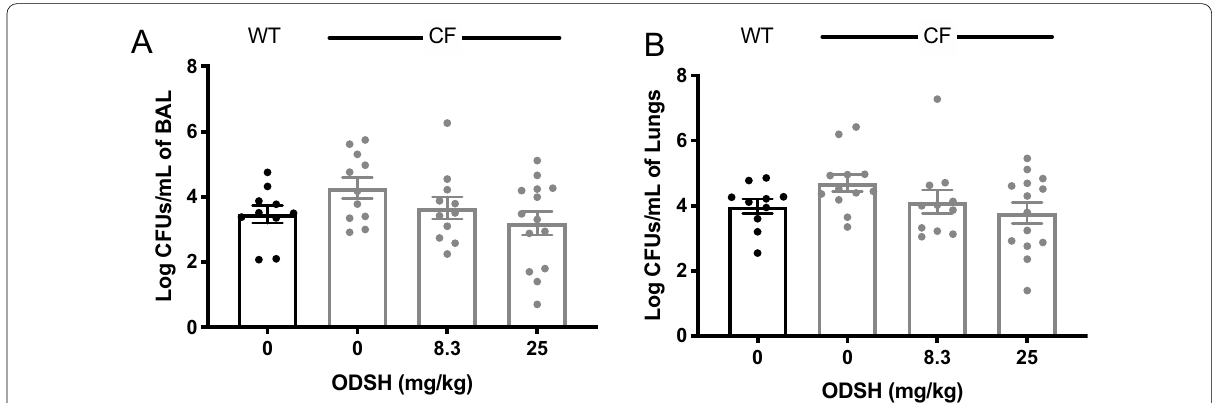
Fig. 2 ODSH improves bacterial clearance in BALF and lung tissues of CF mice. C57BL/6 mice (WT) and CFTR −/− mice (CF) were intratracheally inoculated with Pseudomonas aeruginosa (PA) at T 0 and were randomized to receive via i.p. administration of saline or ODSH at 8.3 or 25 mg/kg = at T 0 and 12 h. A Bronchoalveolar lavage fluid (BALF) and B lung homogenate were harvested 18 h after infection (T 18 h) and were analyzed = = for the amount of viable bacteria by plating serial dilutions of BALF samples followed by colony assay. Bacterial load in the samples is expressed as log CFUs/mL in BALF or lungs. Data represent the mean SEM of four independent experiments (n 10–14). One-way ANOVA was used for ± = multiple group comparison to determine statistical significance between control CF group and other